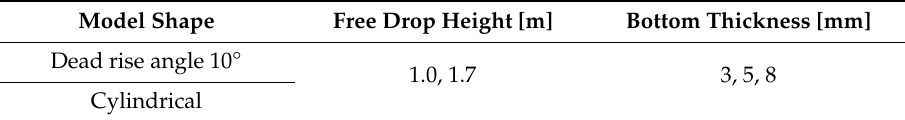
Table 1. Free drop test conditions.